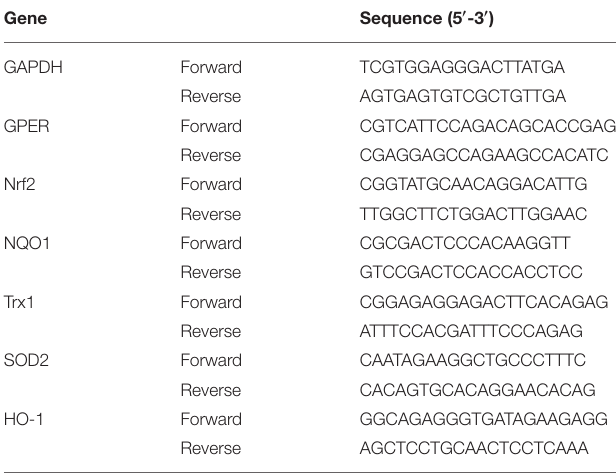
TABLE 1 | Human Primers used in quantitative-polymerase chain reaction (Q-PCR). Gene